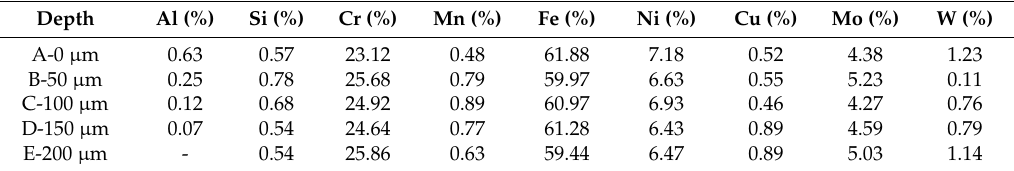
Table 3. Chemical analysis depth profile with a 50- µ m spacing, referring to the areas highlighted in Figure 10.